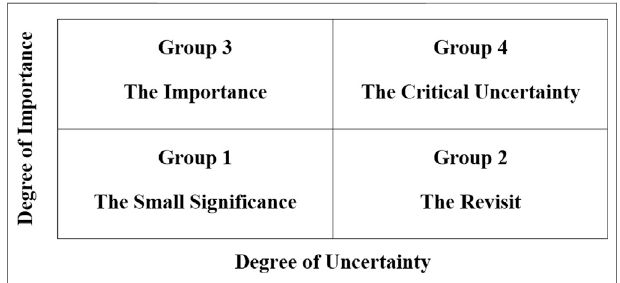
FIGURE 4 | Importance-uncertainty matrix (Rialland and Wold,